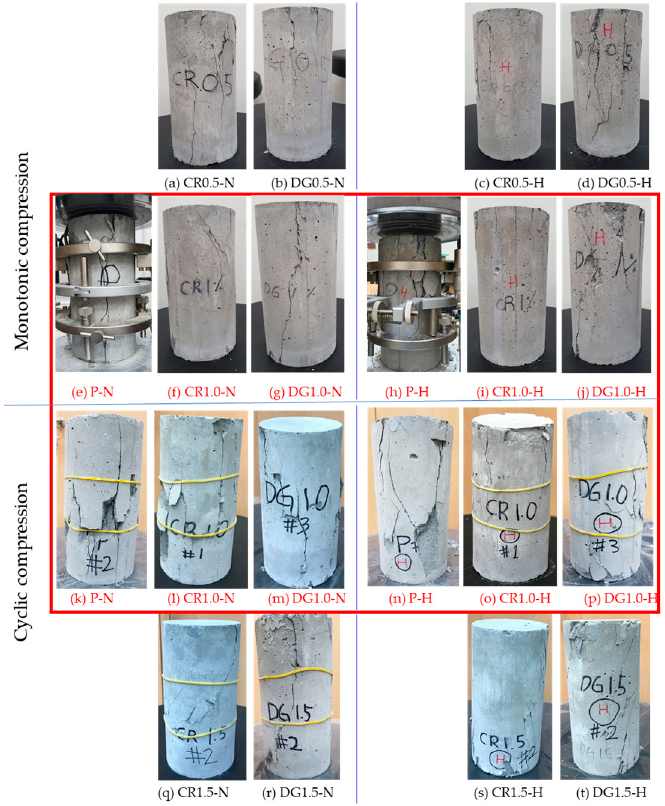
Figure 17. Failure of specimens under monotonic and cyclic compressive loads ( a ) CR0.5-N specimen, (b) DG0.5-N specimen, ( c ) CR0.5-H specimen, ( d ) DG0.5-H specimen, ( e ) P-N specimen, ( f ) CR1.0-N specimen, ( g ) DG0.5-N specimen, ( h ) P-H specimen, ( i ) CR1.0-H specimen, ( j ) DG1.0-H specimen, ( k ) P-N specimen in cyclic test, ( l ) CR1.0-N specimen in cyclic test, ( m ) DG1.0-N specimen in cyclic test, ( n ) P-H specimen in cyclic test, ( o ) CR1.0-H specimen in cyclic test, ( p ) DG1.0-H specimen in cyclic test, ( q ) CR1.5-N specimen in cyclic test, ( r ) DG1.5-N specimen in cyclic test, ( s ) CR1.5-H specimen in cyclic test, ( t ) DG1.0-H specimen in cyclic test.